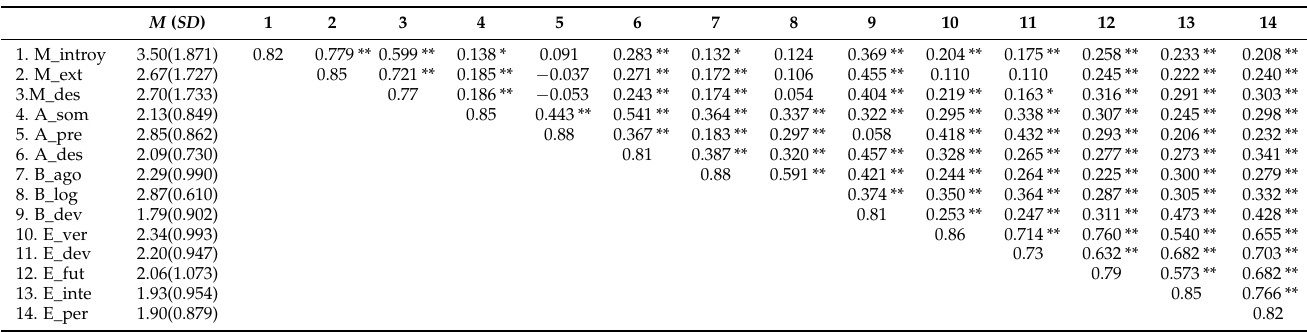
Table 1. Descriptive statistics and Pearson correlations.